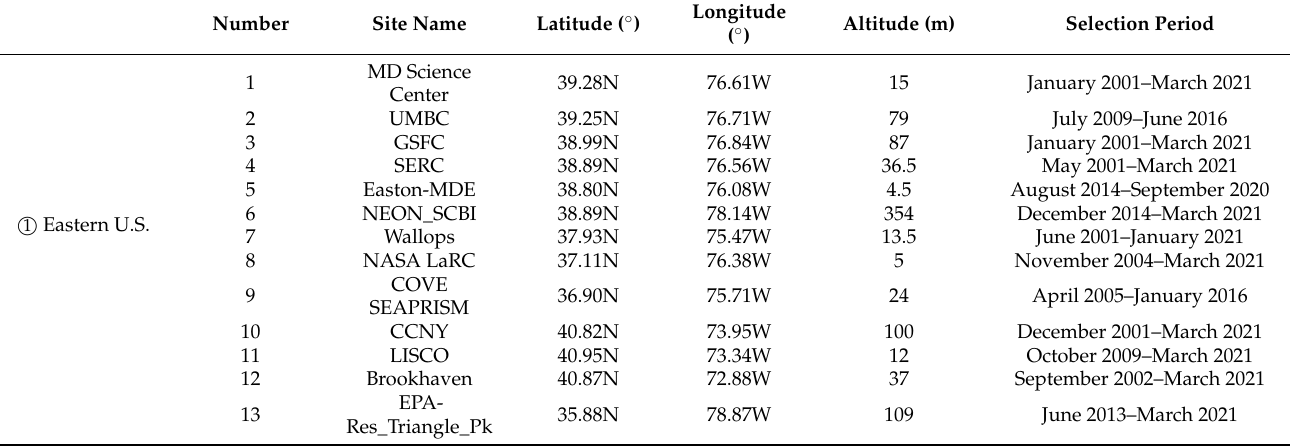
Figure A1. The six regional sites of AERONET are marked on the map. The regions ① — ⑥ represent eastern U.S., northern Europe, northern Europe, northern China, eastern China, and South Korea, respectively. The six figures around the world map represent the detailed distribution map of the selected AERONET site locations in each region. The numbers in the figure correspond to the information of each corresponding numbered site in Table A1; where the color bar represents altitude, it should be noted that the figure omits six detailed figures of the color bar with an altitude range of 0~2 km. Table A1. The information of the AERONET